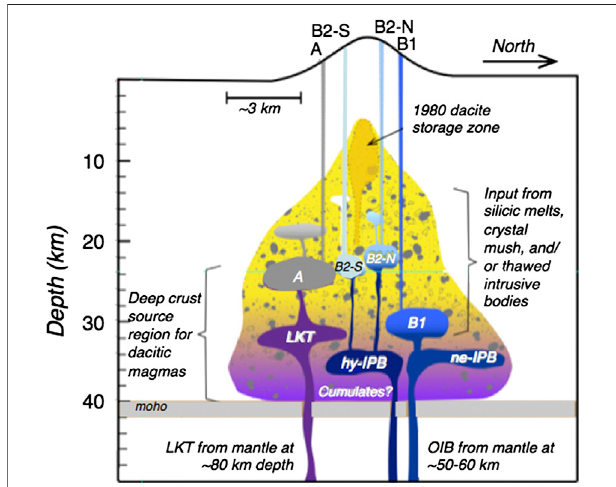
FIGURE 5 | Schematic cross-section showing inferred depth relations for crustal-level Mount St. Helens (MSH) magma reservoirs and plumbing systemasdescribedinLeemanandSmith(2018);notethathorizontalscaleis greatly expanded. In this case, depths are computed using the thermobarometer of Lee et al. (2009) and based on compositions of the most MgO-rich Cave basalt (LKT) and Castle Creek basalts (OIB-like) of both nepheline- and hypersthene-normative character. Reservoirs feeding these eruptions are, respectively, “ A, ” “ B1, ” and “ B2-S ” / “ B2-N ”— the latter for hy- normative lavas vented high on the south and north fl anks of MSH. Multiple fl ows from these vents exhibit compositional variations due to mixing with andesitic material within the magmatic system. Diagram also shows implied feeder conduits to deeper mantle sources of the respective LKT and OIB-like primary magmas (below diagram). Additional shallower reservoirs are inferred to exist as ultimate sources for more evolved magmas at MSH; formation and storage depths of evolved dacitic magmas are discussed by Blatter et al.